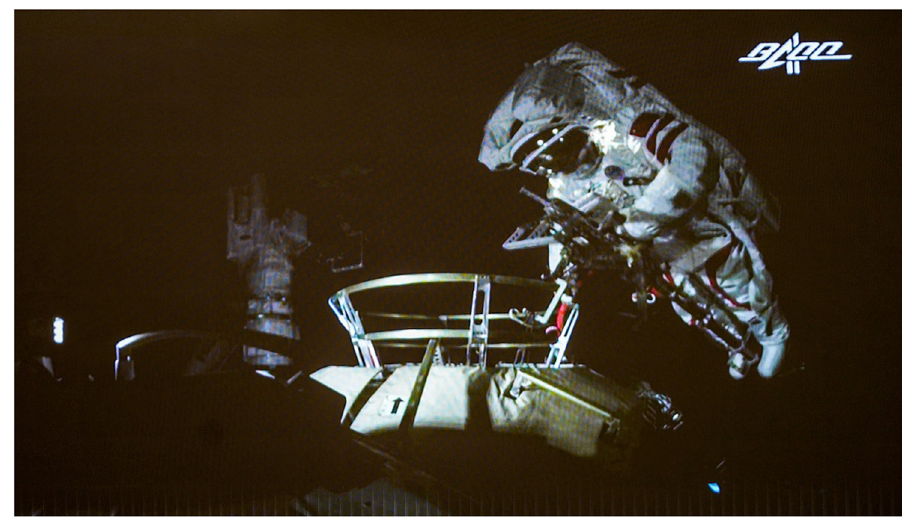
Figure 1: Astronauts leave the capsule in the Shenzhou 12 Mission.